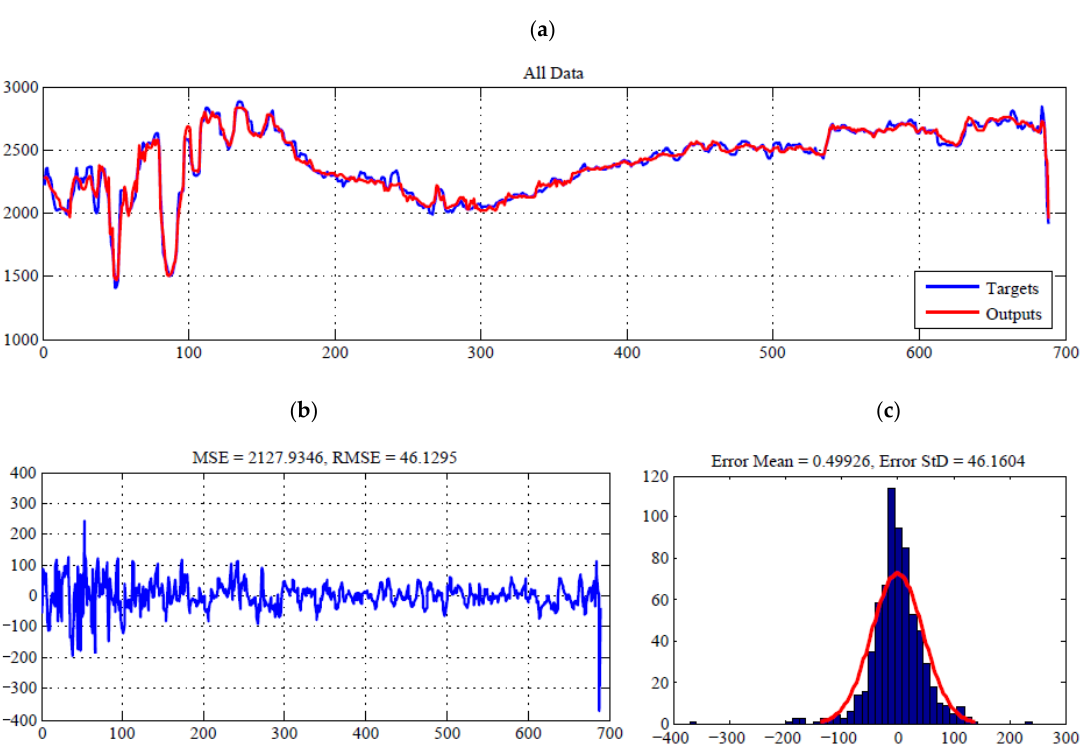
Figure 7. ( a ): the estimated shear wave velocity; ( b ): evaluation of MSE and RMSE metrics; and ( c ): error distribution for all data.